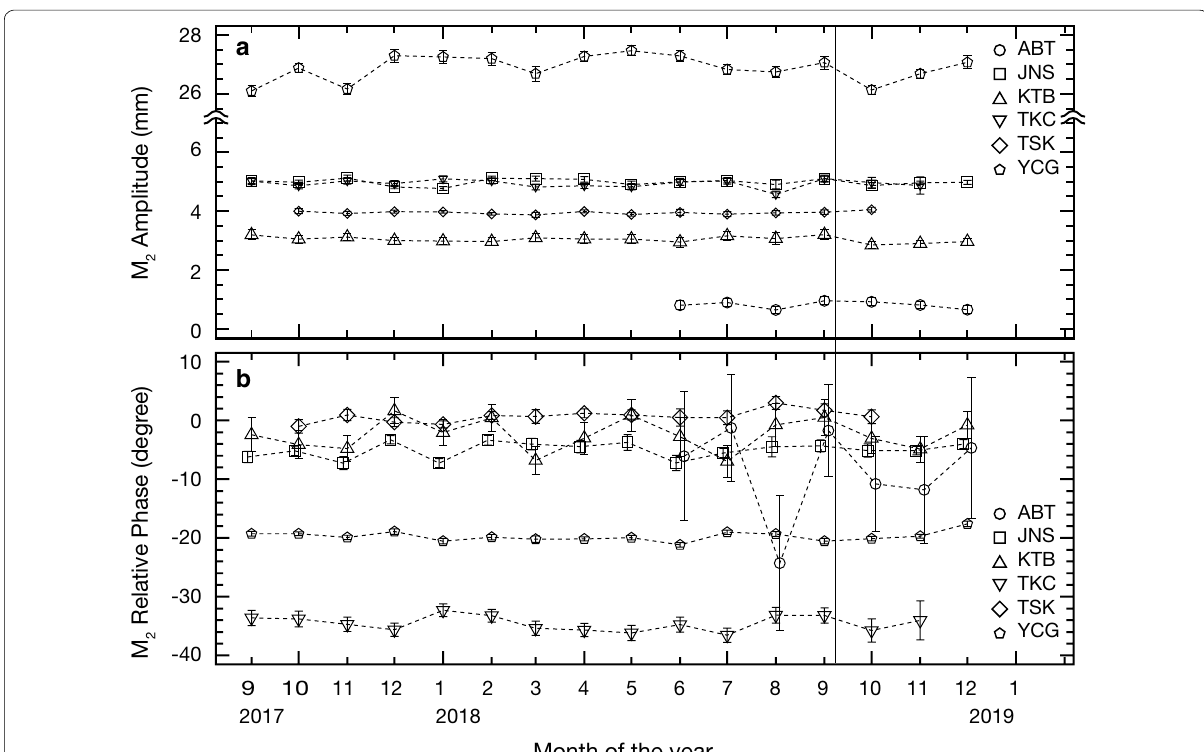
Fig. 4 Amplitude responses and phase shifts of the M 2 tidal constituent (period: 12.4206 h) with respect to the phase in the GOTIC2 data between September 2017 and October 2018. Error bars are one sigma. The responses were calculated every 31 days using the BAYTAP‑G tidal analysis software. The solid line indicates the timing of the earthquake